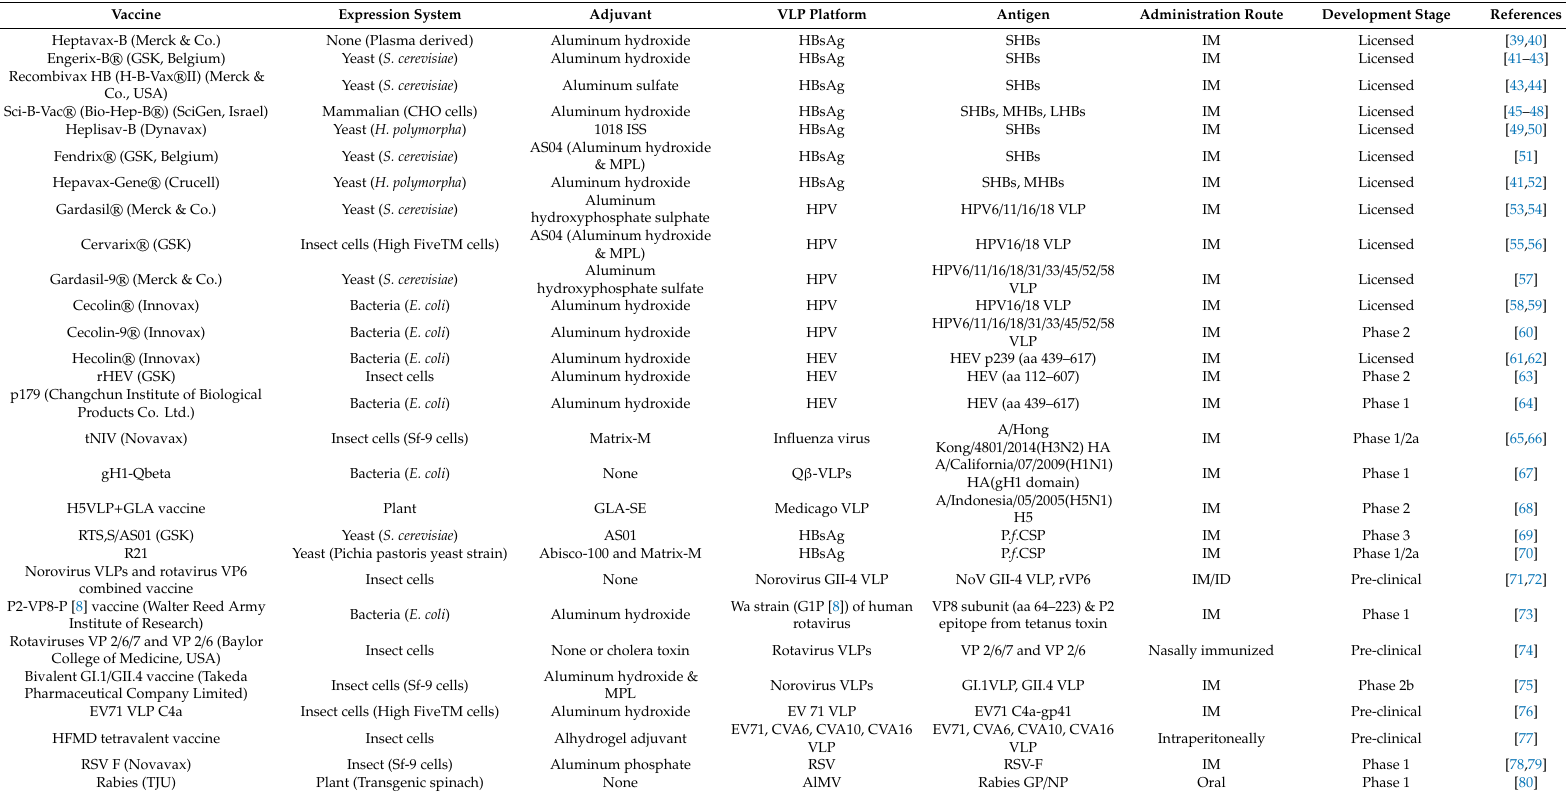
* Abbreviations: HBsAg: hepatitis B surface antigen; SHBs: small S hepatitis B surface antigen; MHBs: middle Pre-S2 HBV peptide; LHBs: large Pre-S1 envelope protein; IM: intramuscular injection; GSK: GlaxoSmithKline; S. cerevisiae : Saccharomyces cerevisiae ; ID: intradermally; CHO cells: Chinese hamster ovary cells; H. polymorpha : Hansenula polymorpha ; ISS: immunostimulatory sequences; HPV: human papillomavirus; E. coli : Escherichia coli ; HEV: hepatitis E Virus; Sf-9 cells: spodoptera frugiperda cells; H3N2,H1N1,and H5N1: a subtypes of influenza viruses; HA: hemagglutinin; Q β -VLPs: RNA bacteriophage Qbeta VLPs; GLA-SE: glucopyranosyl lipid adjuvant-stable emulsion; H5: the A / Indonesia / 05 / 2005 H5N1 influenza hemagglutinin protein; P. f .: Plasmodium falciparum ; CSP: circumsporozoite protein; VP2 / 6 / 7 / 8: rotavirus capsid protein; MPL: monophosphoryl lipid A; EV: enterovirus; CV: coxsackieviruses; HFMD: hand, foot, and mouth disease; RSV: respiratory syncytial virus; RSV-F: the F protein ectodomain of respiratory syncytial virus; AIMV: alfalfa mosaic virus; GP: glycoprotein; NP: